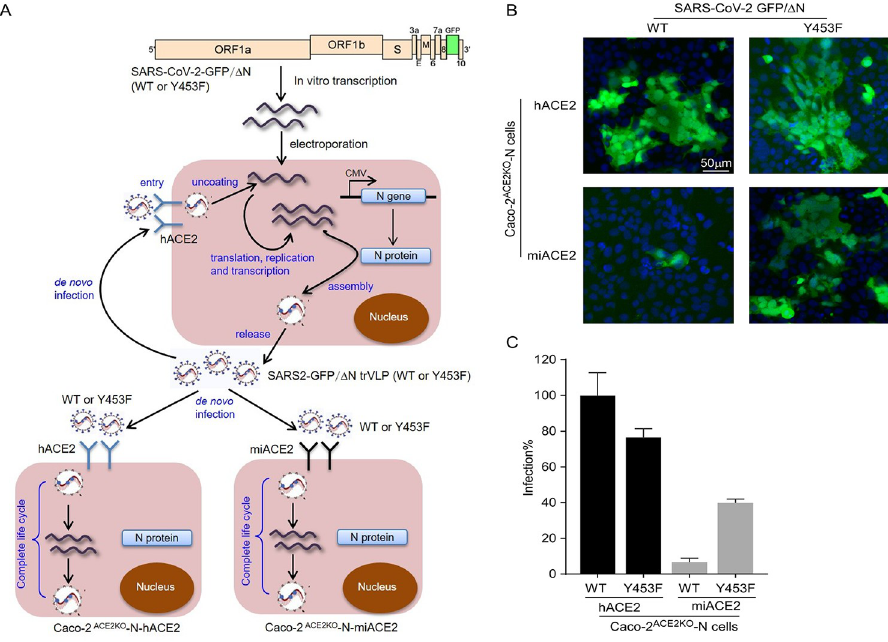
Fig 6. Y453F mutation in spike protein promote SARS-CoV-2 GFP/ Δ N trVLP infection of Caco-2 ACE2KO cells expressing exogenous mink ACE2. (A) Schematic representation of the experiment. SARS-CoV-2 GFP/ Δ N trVLP (WT or Y453F) were produced as previously described[26]. The trVLP were used to infect cells as indicated. (B-C) Endogenous ACE2 knockout Caco-2 cells expressing SARS-CoV-2 N protein were infected with SARS-CoV-2 GFP/ Δ N (MOI = 0.1). After 36 hours, GFP expression was observed using immunofluorescence microscopy and GFP- positive cells were quantified by flow cytometry. All infections were performed in triplicate, and the data are pooled from two independent experiments (mean ±